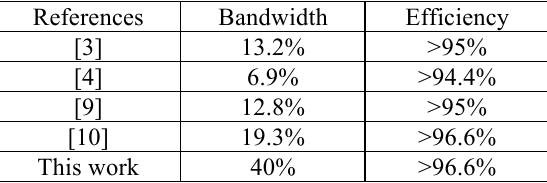
Figure 6: TE , TE and TE suppression at the 10 30 40 output port. They are the S parameters when at the 21 input port the fundamental mode is excited and at the output port other modes are investigated. Table 2: Performance comparison between other mode transformers